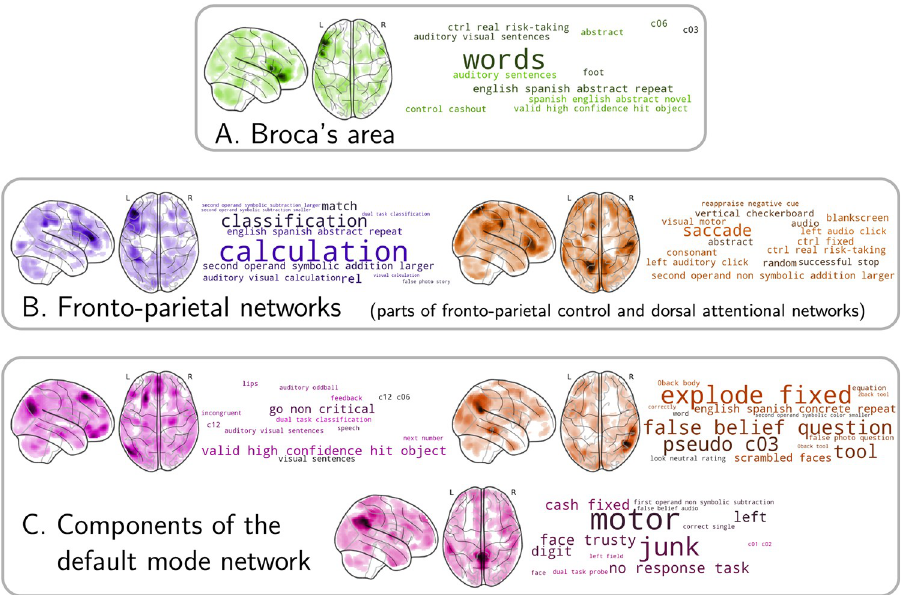
Fig 5. Task-optimized networks associated with high-level functions. Some MSTONs outline brain-circuits that are associated with language, e.g. Broca’s area (A) , or more abstract functions, e.g. fronto-parietal networks (B) or even part of the default mode network (C) . Those networks are more distributed than the ones displayed in Fig 4, but are associated with relatively interpretable word-clouds.